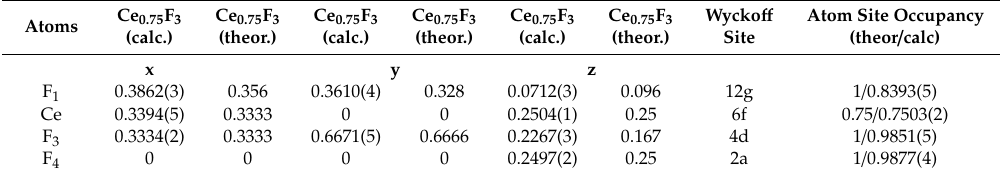
Table 2. Atomic site occupancy for Tb 3+ doped CeF 3 nanocrystalline powders.